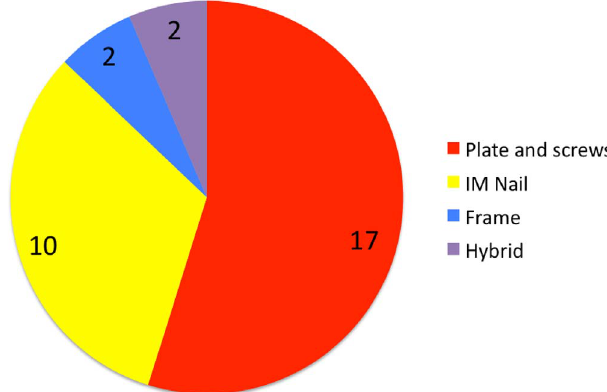
Figure 2. Pie chart demonstrating fracture location for patients included within